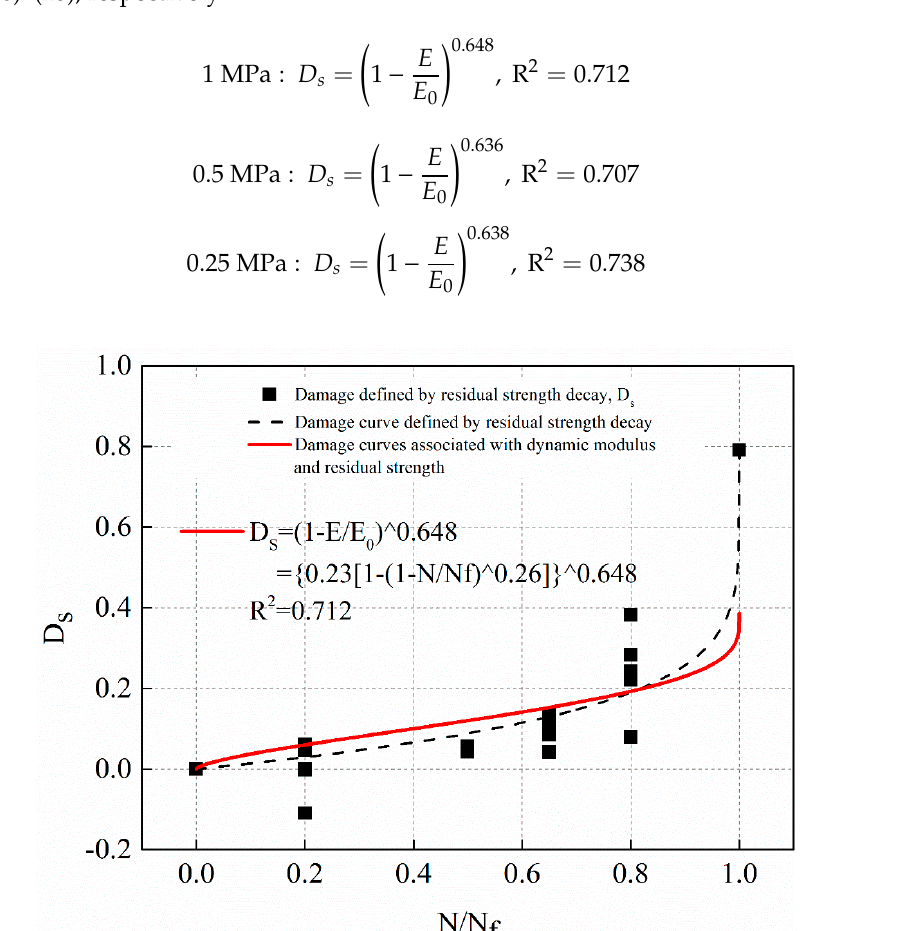
Figure 23. The damage evolution curve associated with dynamic modulus and residual strength with stress levels of 1 MPa.